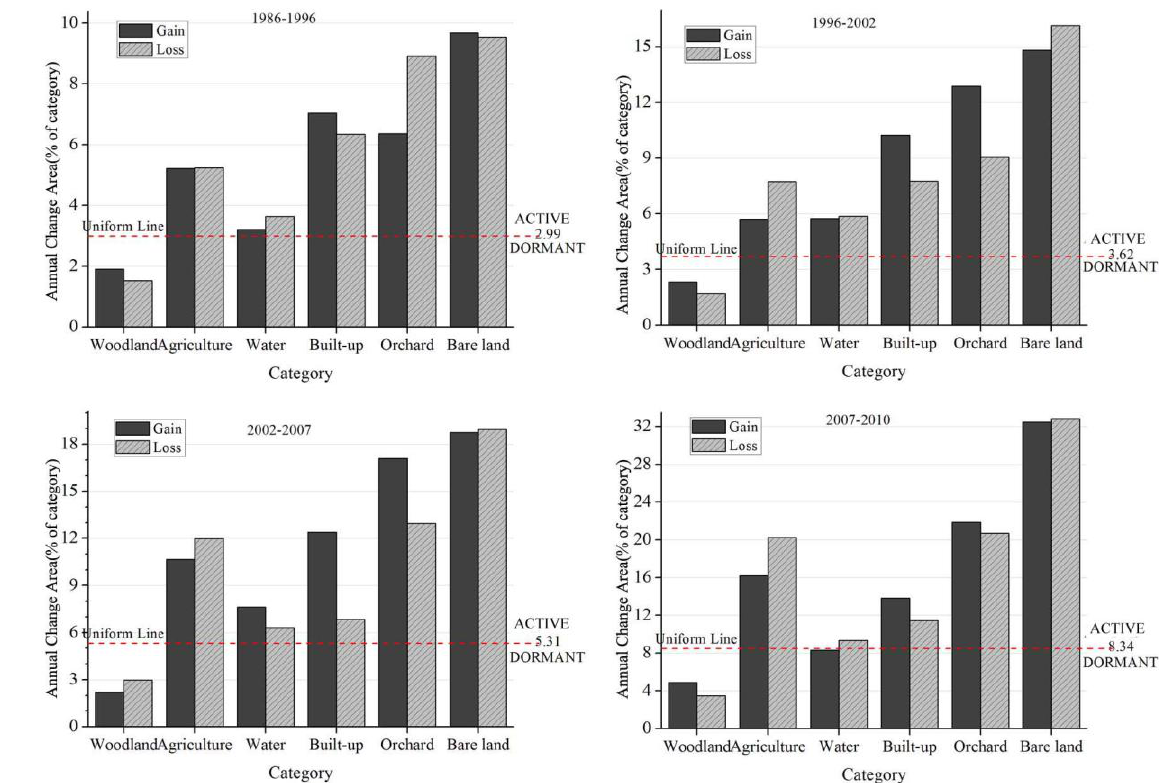
Figure 8. Category level intensity analysis, given the observed change during four time